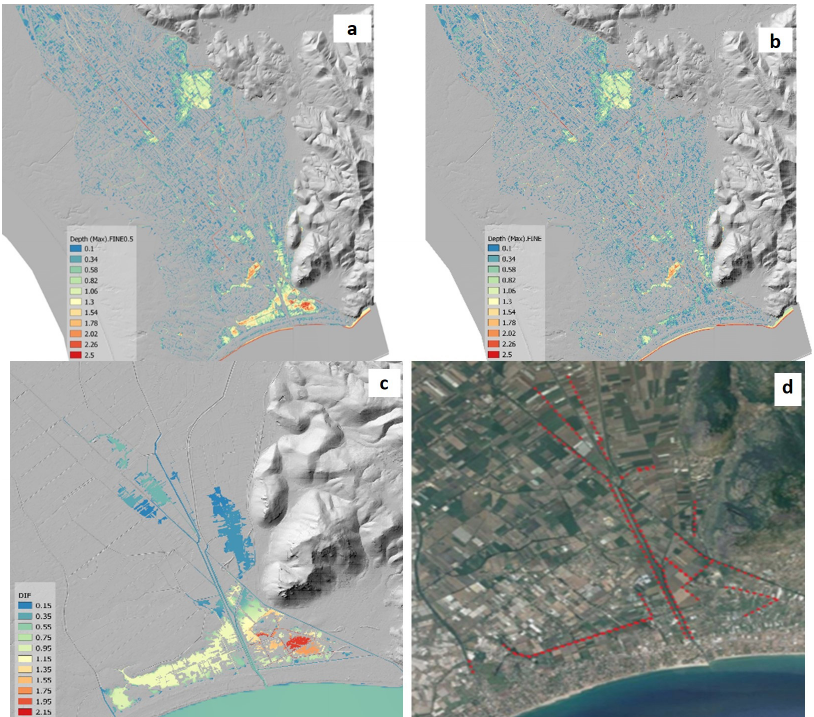
Figure 9. ( a – d ) Comparison of the water depth field at the instant of maximum flooding for the current average sea level and that assuming an average sea level rise equal to m. 0.5.